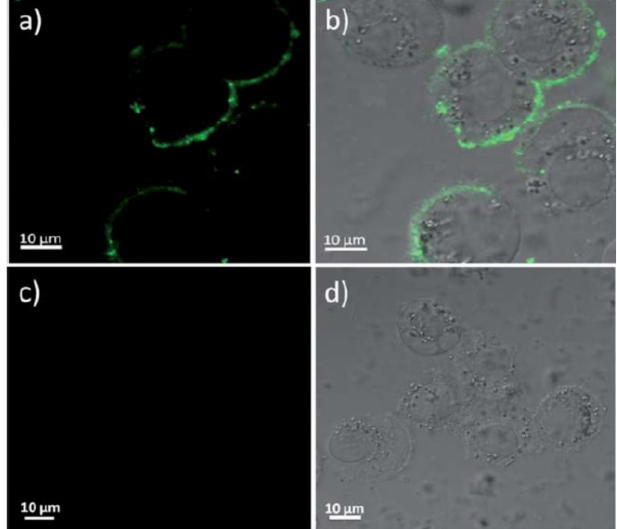
Figure 9. Confocal fluorescence images of HT-29 cells labeled with cyclic RGDfK tagged PEG-PFBD 42 dots after 15 min incubation at room temperature (top row) and non-functionalized PEG-PFBD dots (bottom row). Scale bar: 10 µ m. Reproduced with permission [56]. Copyright: 2012, Royal Society of